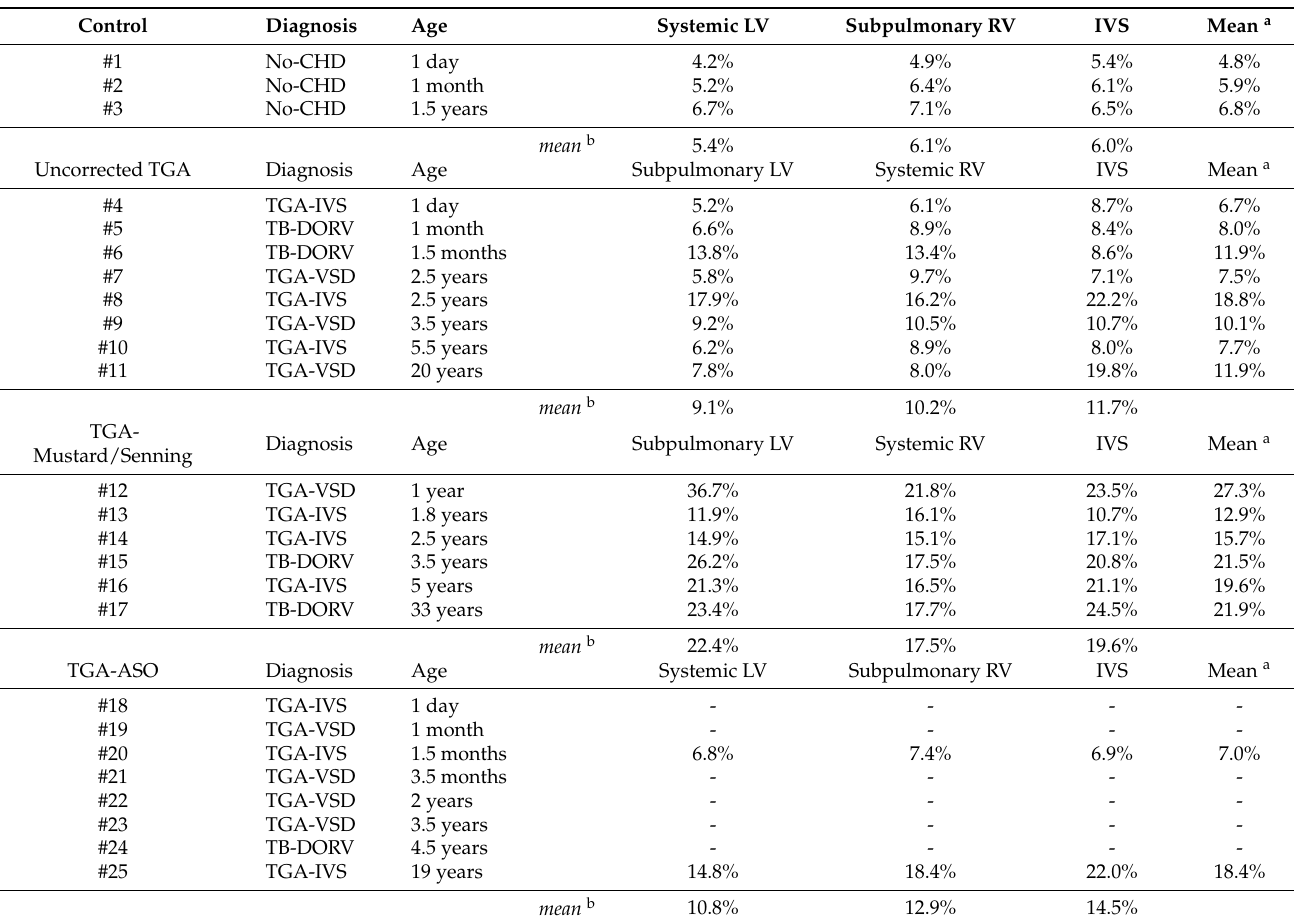
Table 2. Quantification of fibrosis in control, uncorrected TGA, TGA-Mustard/Senning, and TGA-